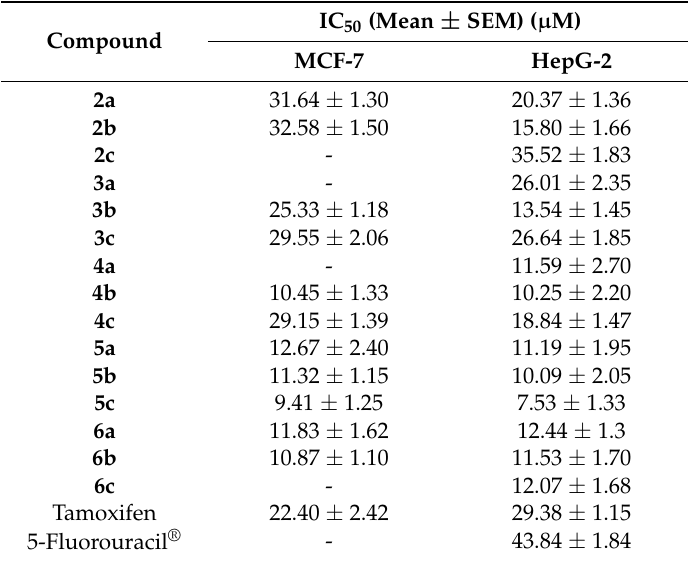
Table 1. IC 50 of the tested compounds 2 – 6 against MCF-7 and HepG-2 cell